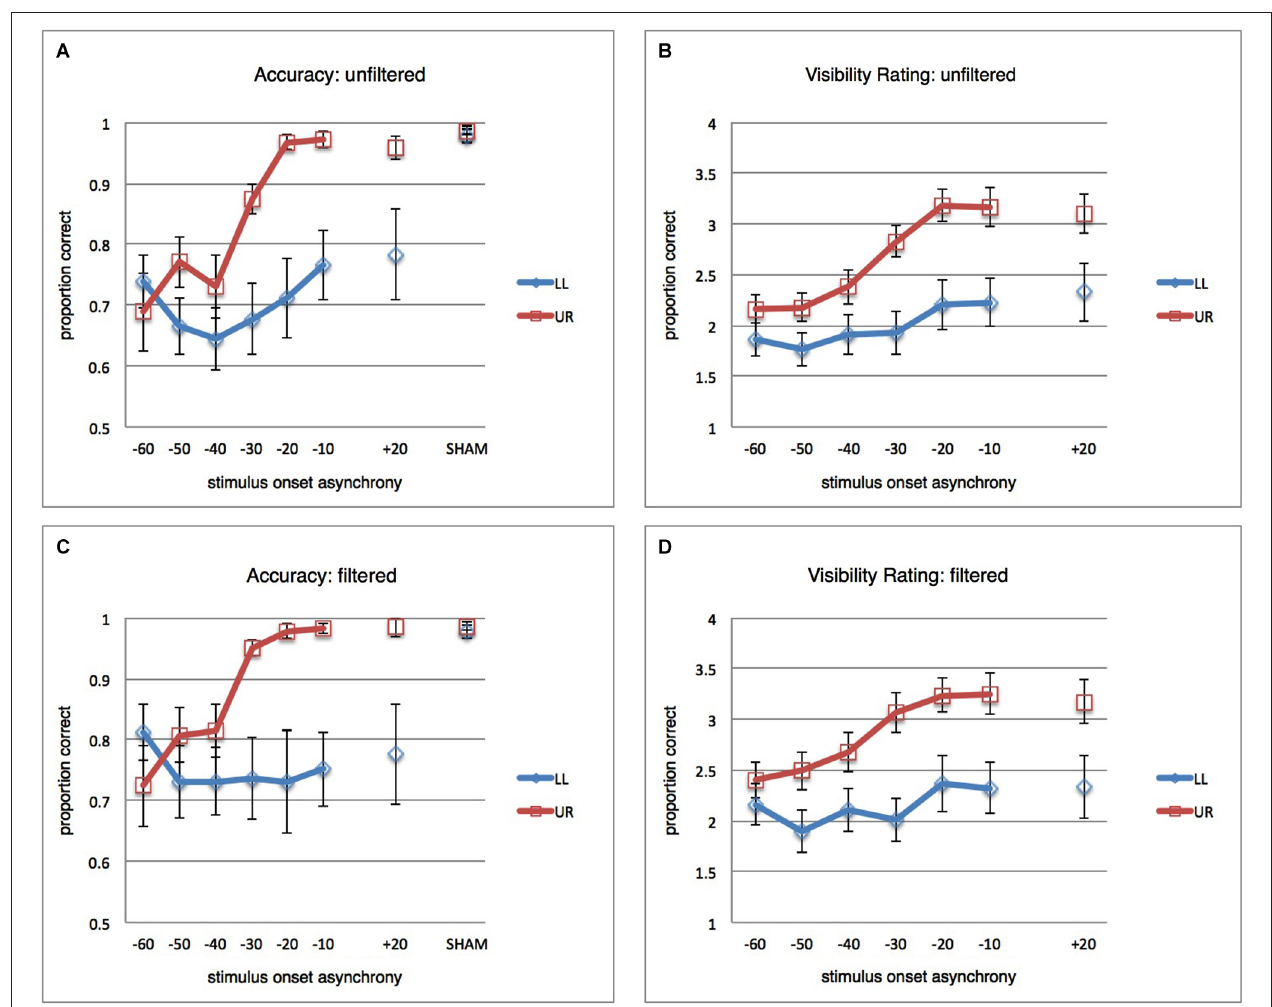
important observation is that TMS disrupts visual performance spatially non-specifically for the earliest SOAs ( − 60, − 50, − 40 ms) and spatially specifically for the later SOAs ( − 30, − 20, − 10 ms). (B) Average ratings of stimulus orientation visibility (subjective report on a 4-point scale) over participants ( n = 12). (C) Same as in (A) , but for filtered data: All trials removed that had any indication of eye blink or partial pupil covering in a conservative window of − 200 to +300 ms from visual stimulus onset. (D) Same as in (B) , but for filtered